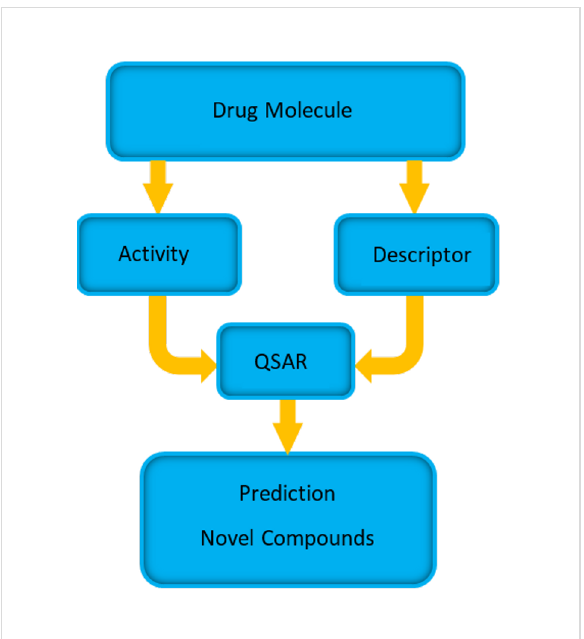
Figure 8: Schematic diagram showing the steps involved in QSAR. Known drug molecule activity and descriptor data is obtained and the mathematical model of QSAR is built such that descriptors can predict the activity of each molecule. The predictive power of models are vali- dated and used in predicting activities of novel